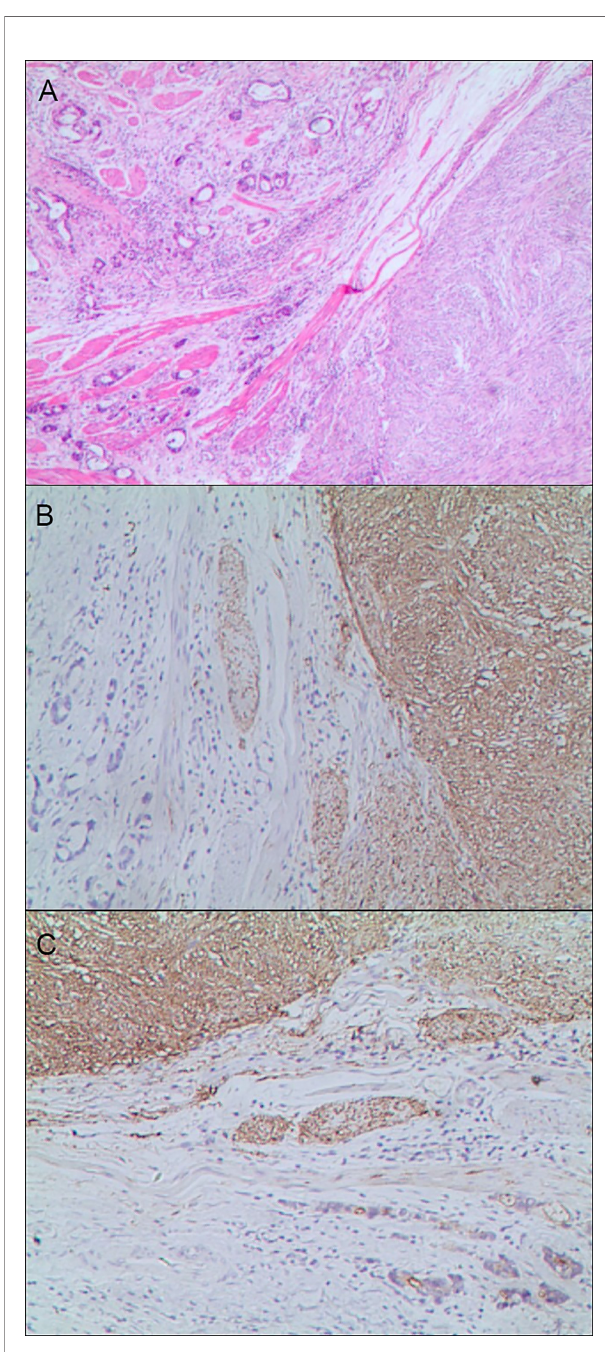
FIGURE 6 | Gastric mixed tumors. (A) Gastric mixed gastrointestinal stromal tumor with low nuclear fi ssion rate (80% tubular adenocarcinoma with moderately differentiated gastrointestinal stromal tumor/20% tubular adenocarcinoma), hematoxylin and eosin staining × 20. (B) Immunohistochemical staining of gastrointestinal stromal tumor showed CD117 was partially positive. En Vision method × 20. (C) . Gastrointestinal stromal tumor showed DOG1 was partially positive. En Vision method ×